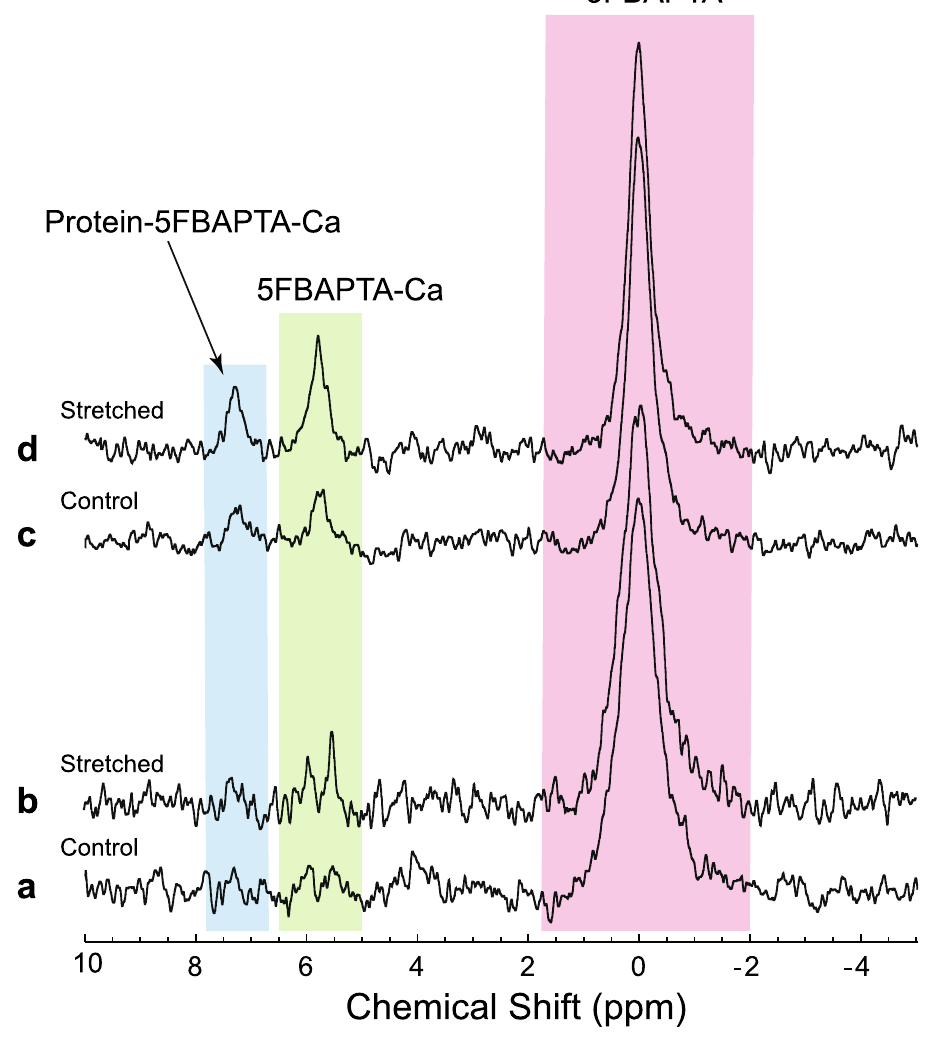
Figure 1. Net Ca 2+ entry into RBCs after being stretched to 75% in gel for 42 h at 20 °C. The 19 F NMR spectra were recorded at 37 °C after extracting the RBCs from the gel, using the protocol of Fig. S2. The pink highlighting indicates free intracellular 5FBAPTA, green, the Ca 2+ complex of 5FBAPTA, and blue, the ternary complex between Ca 2+ and protein inside the cells. ( a ) Control (relaxed) RBC-gel; ( b ) the stretched sample; ( c ) sample ( a ) frozen and thawed in liquid nitrogen to lyse the RBCs; ( d ) sample ( b ) treated as for ( c ) NMR settings: 5-mm 19 F probe; 90° pulse duration was 8 µs; each FID was composed of 1024 complex data points; 128 FIDs were accumulated for each spectrum; inter-transient delay was 4.61 s; total accumulation time per spectrum was 10 min; spectral width was 10 kHz (26.71 ppm); and 20 Hz line broadening was applied by exponential multiplication of the